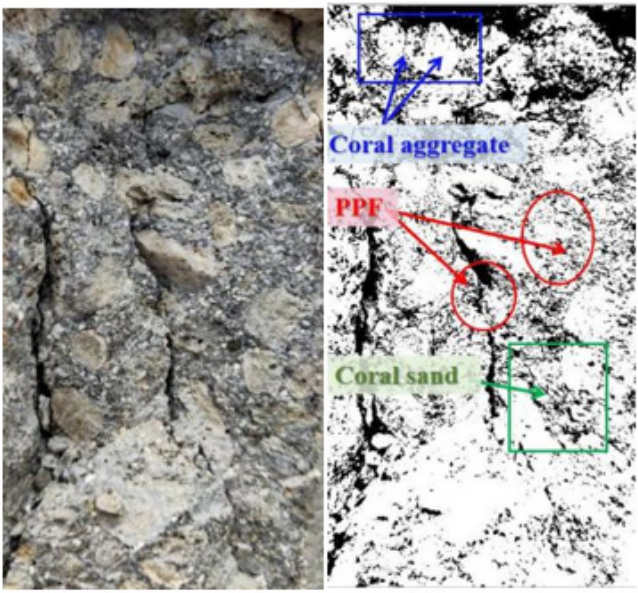
Figure 9. Distribution of fibers and aggregates in longitudinal section.